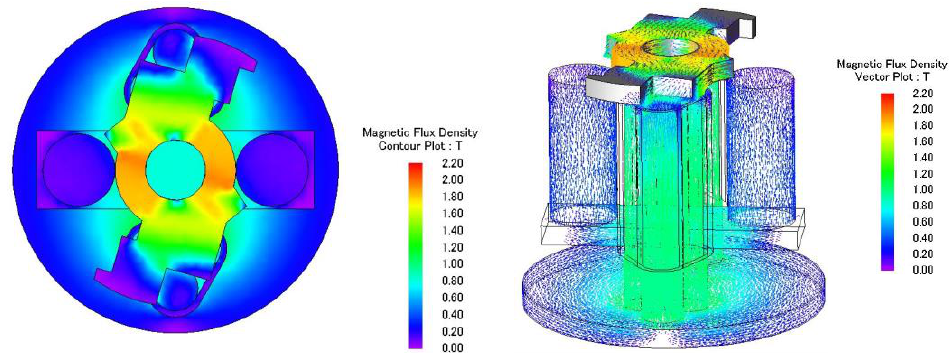
Figure 12. Top view and 3D view of magnetic flux density plots of the motor at a rotating angle of 74°.